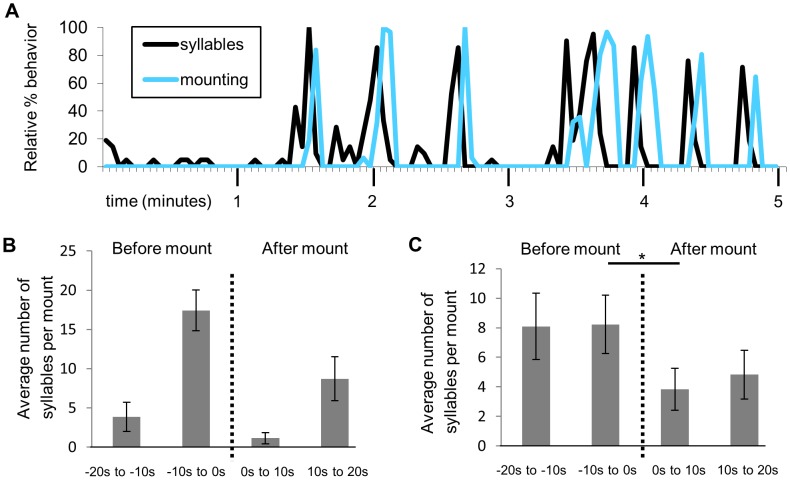
Temporal relationship between USVs and mounting.A) Relative (normalized to max) percent number of all syllables and amount of time spent mounting per 3 second time bin (minor tick marks) for a single 5 minute trial. B) For the same trial, the average number of syllables in the 10 seconds before each mount was higher relative to all other 10 s time bins (bars show SE). C) Across 23 trials with mounting, the number of syllables in the 10 seconds before mounting was significantly higher than the number of syllables in the 10 seconds after mounting (Wilcoxon signed ranks test *p = 0.001); however, there was no difference between the number of syllables in the 10 seconds before mounting and the 20–10 seconds before mounting or the 10 seconds after mounting and the 10 to 20 seconds after mounting.